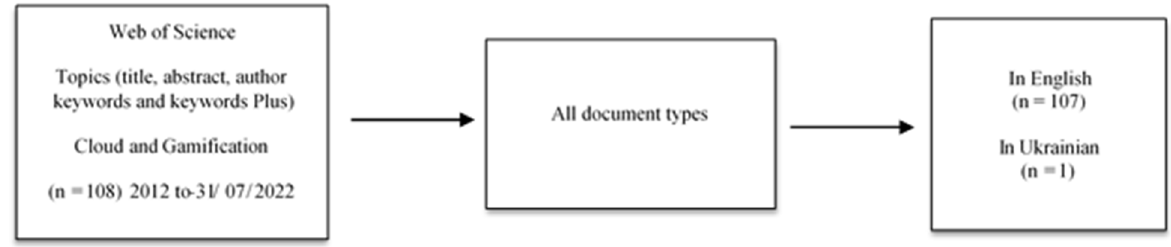
Figure 1. Diagram of the selection and search process.